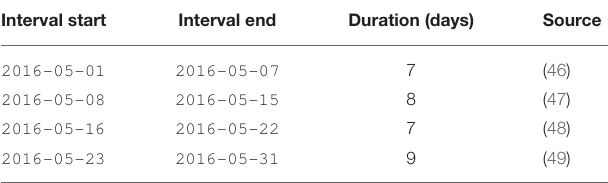
TABLE 5 | Influenza reporting intervals in Poland in May